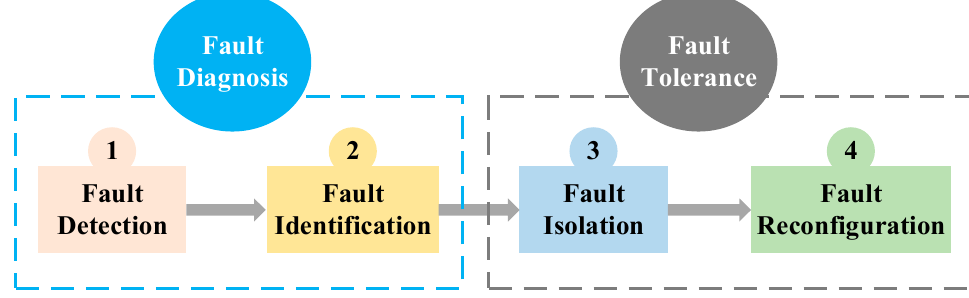
Figure 2. FT MLI operation in case of